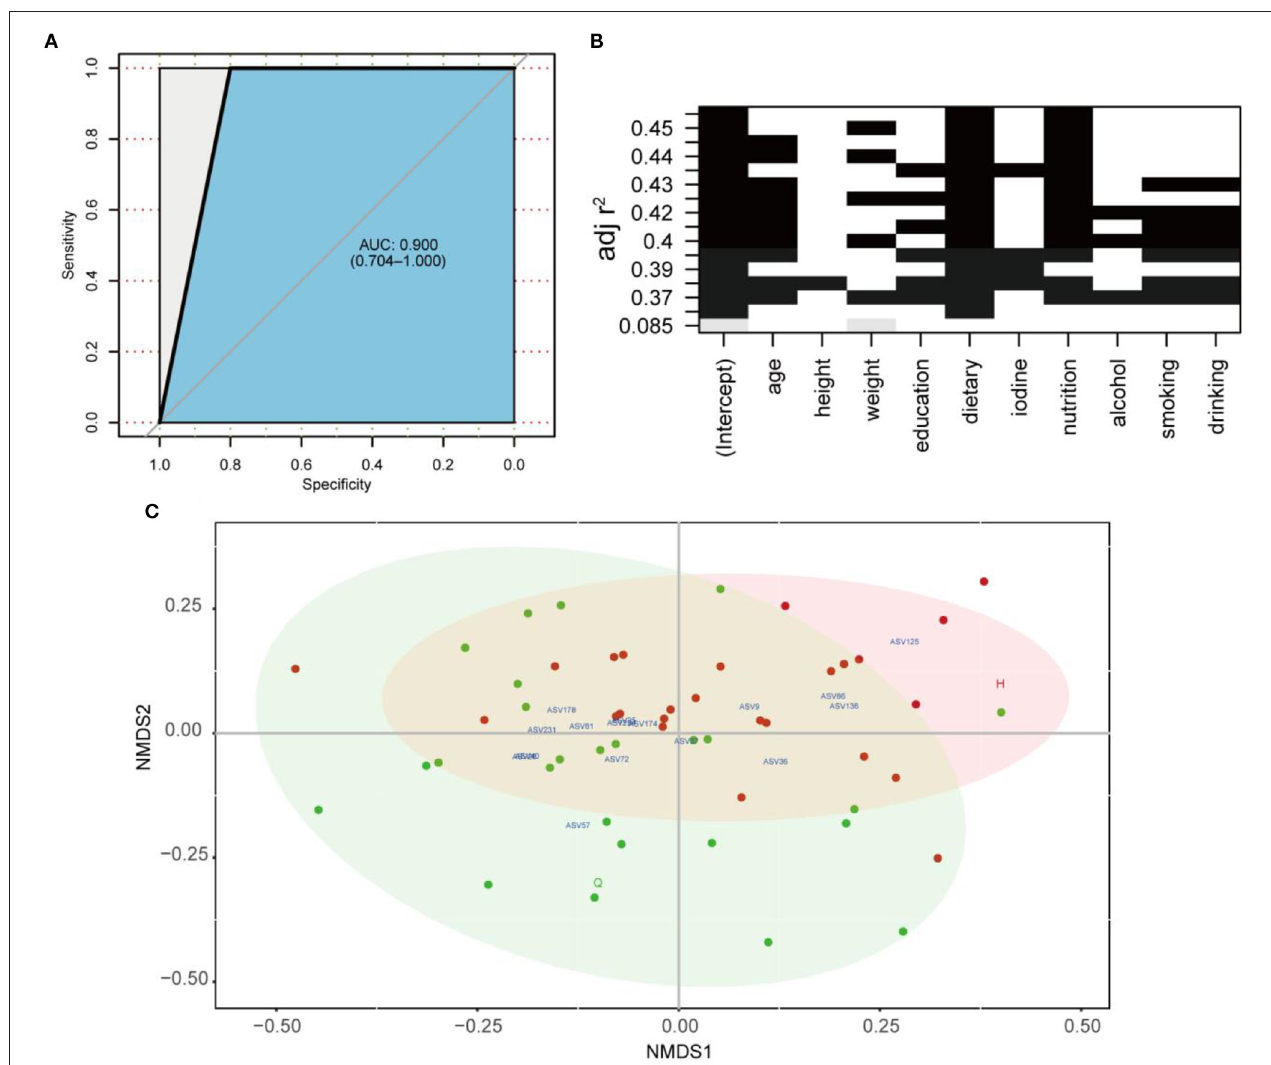
FIGURE 5 | (A) ROC according to 40 samples of the testing set calcualted by cross-validated random forest model. Area under ROC (AUC) and the 95% confidence intervals are also shown. (B) All-subsets Regression. The horizontal axis represents the predictive variables, and the vertical axis represents the accuracy of the regression (adjusted R 2 ), which shows how the accuracy of the regression when different combinations of predictive variables are considered. (C) Non-metric multidimensional scaling (NMDS) based on the Bray–Curtis distances. Core ASVs (DelBet > 0) are labeled blue and projected as biomarkers to different locations pre- or